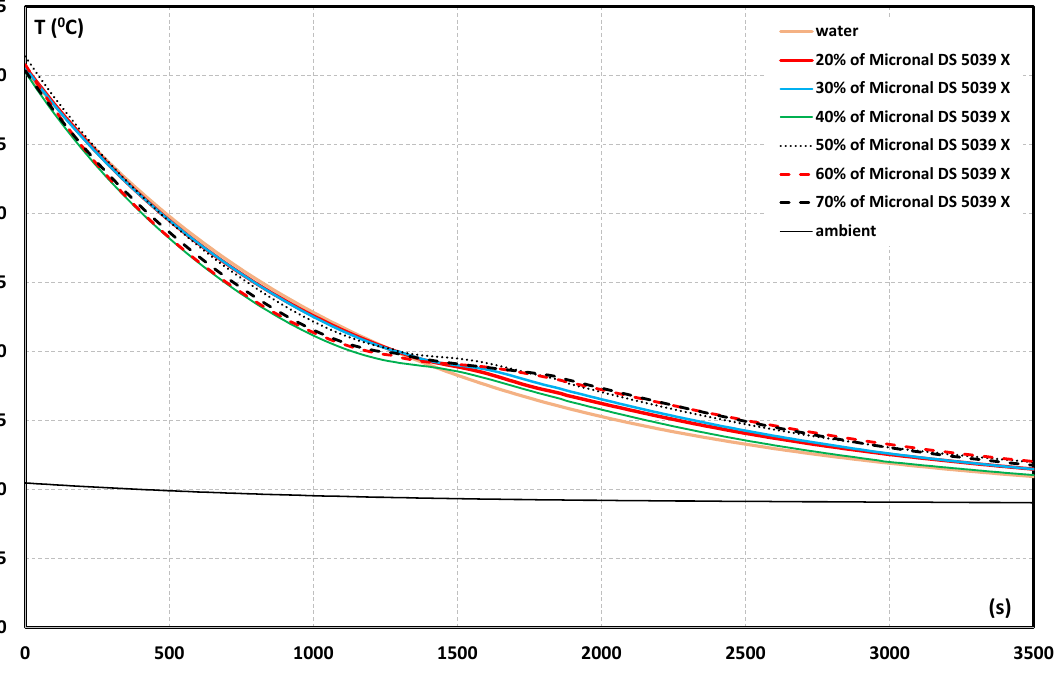
Figure 2. T-history cooling curves for the mPCM slurry, reference liquid (water) and surrounding air.